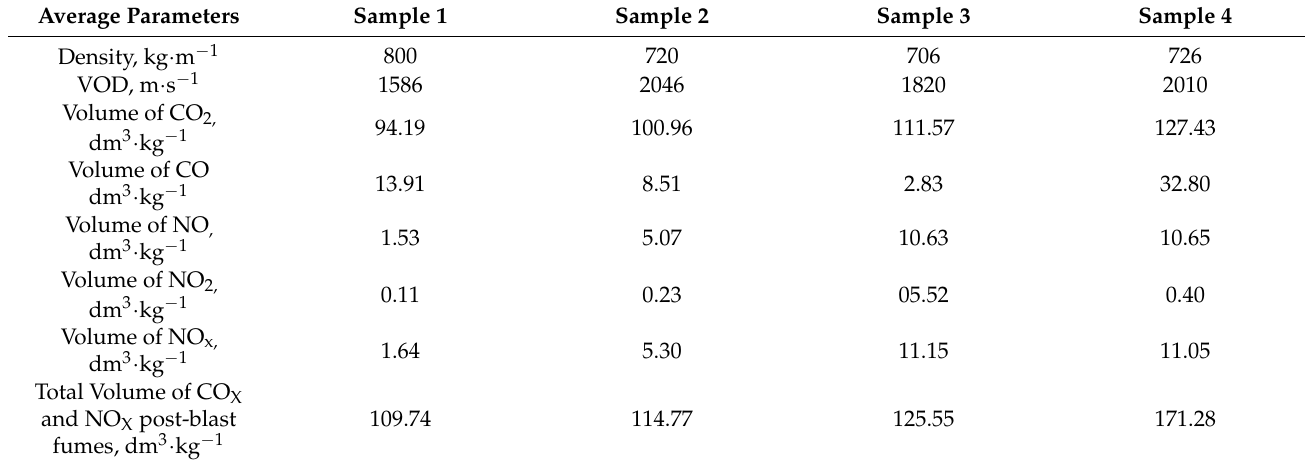
Table 4. In-situ properties of non-ideal explosives with a microstructure charcoal enhancer of − 90 µ m